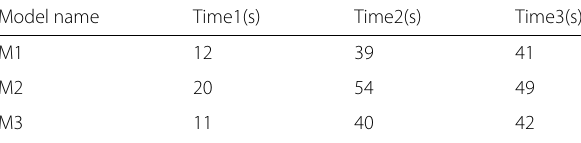
method and proposed